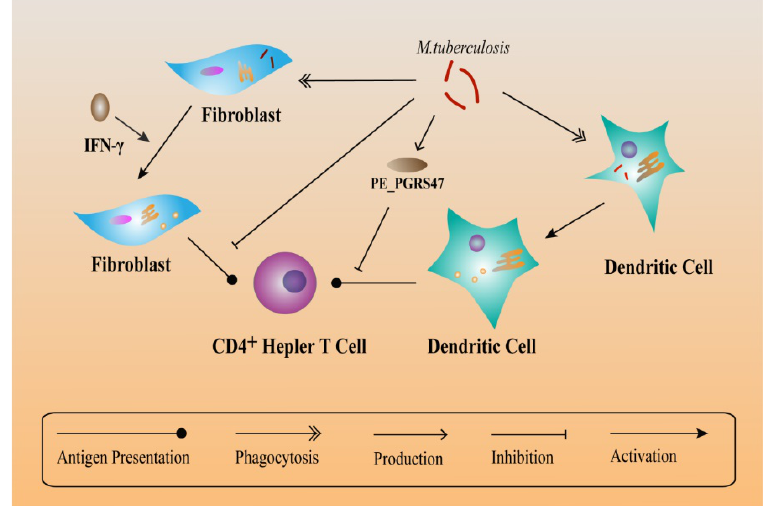
Figure 2. Active (ATBI), latent TB infection (LTBI) or infection granulomas that provide a shelter for bacteria.